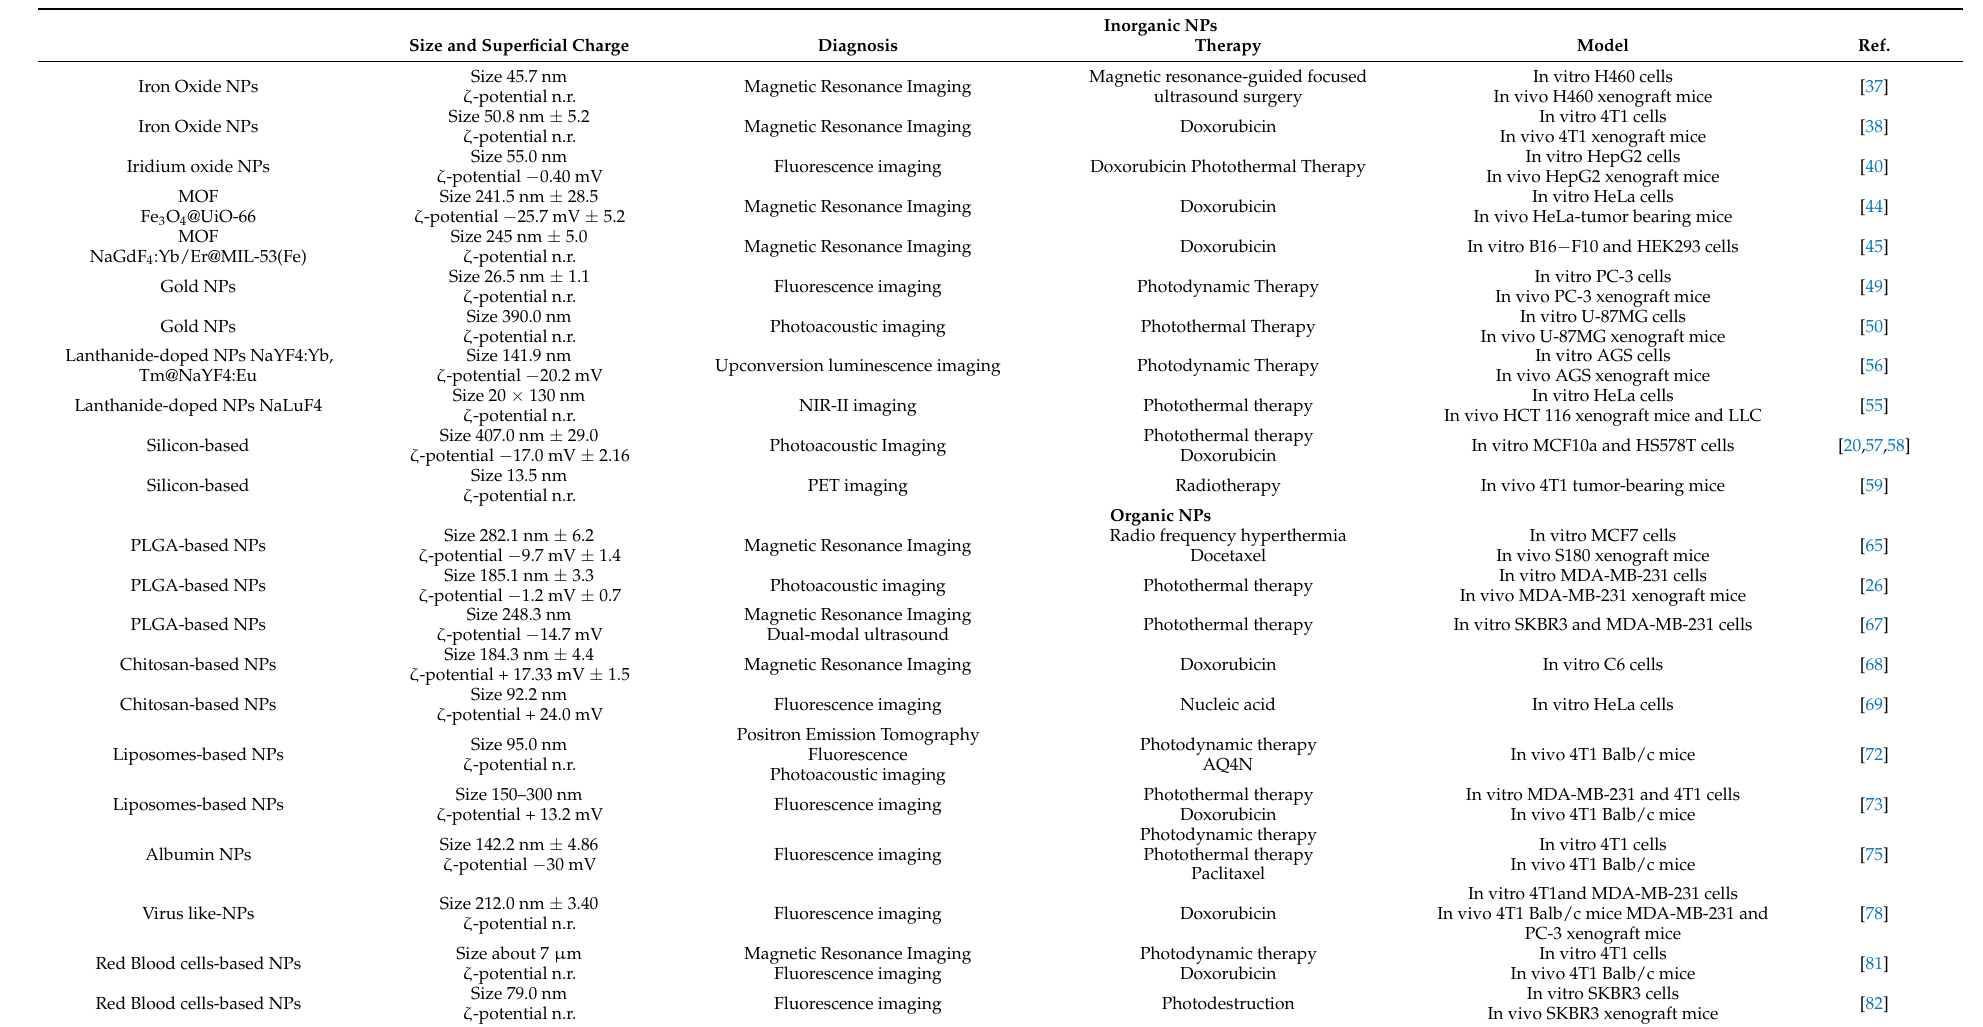
Table 1. Resume of NPs for theranostic applications. not reported: